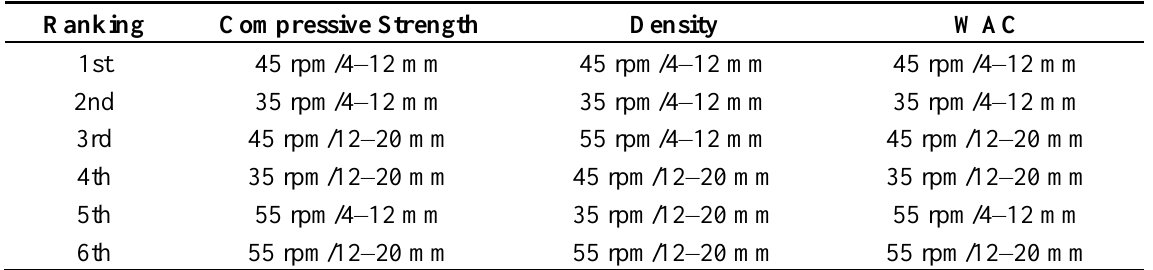
Table 6. Effect of pelletization process on physical and mechanical properties of aggregates.